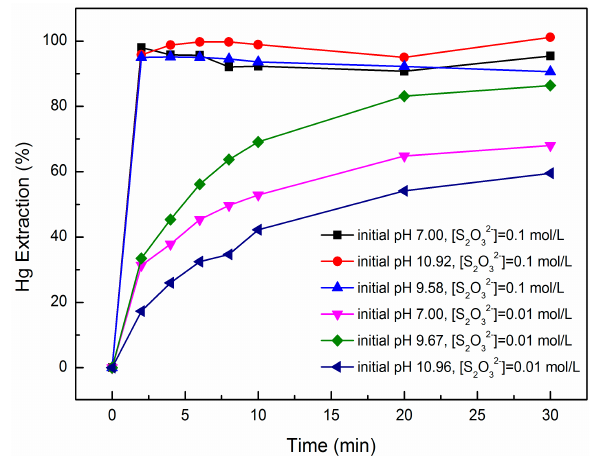
Figure 2. Effect of initial pH on Hg extraction in 0.01 mol/L and 0.1 mol/L Na 2 S 2 O 3 solution (Initially, 0.4 g HgO was mixed with 500 mL Na 2 S 2 O 3 solution, 20 ± 1 °C).